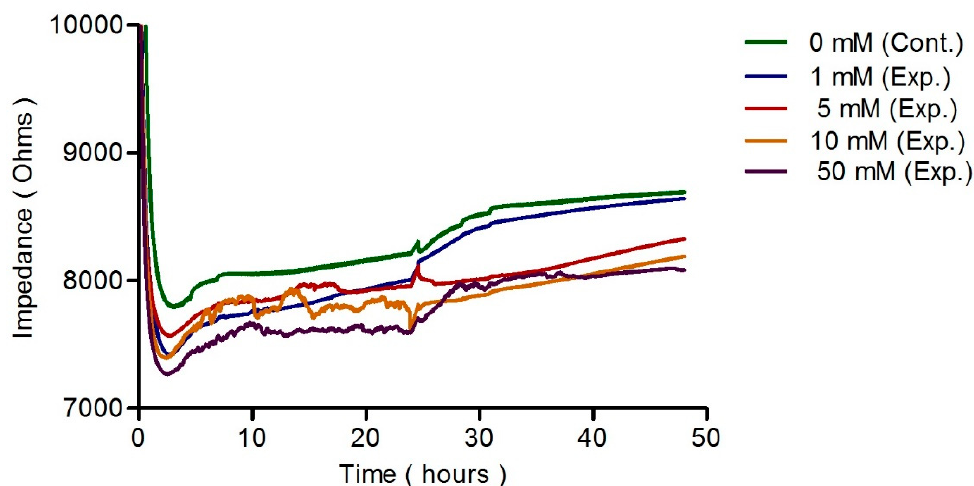
Figure 4. Real-time electric cell-substrate impedance sensing (ECIS) impedance results measuring cytotoxicity in hFOB 1.19 cells in response to di ff erent concentrations of MgO NPs.